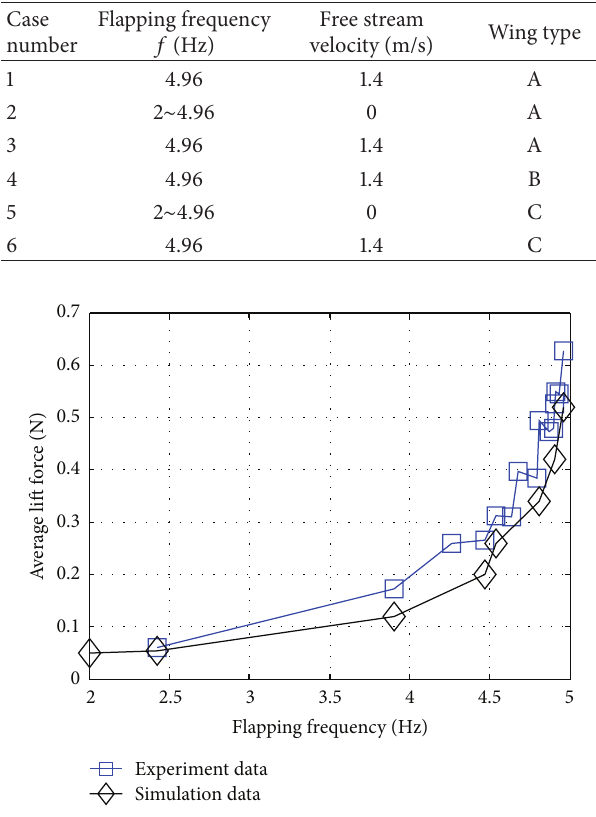
Figure 5: Average lift force based on the different flapping frequen- cies comparing with the experiment.